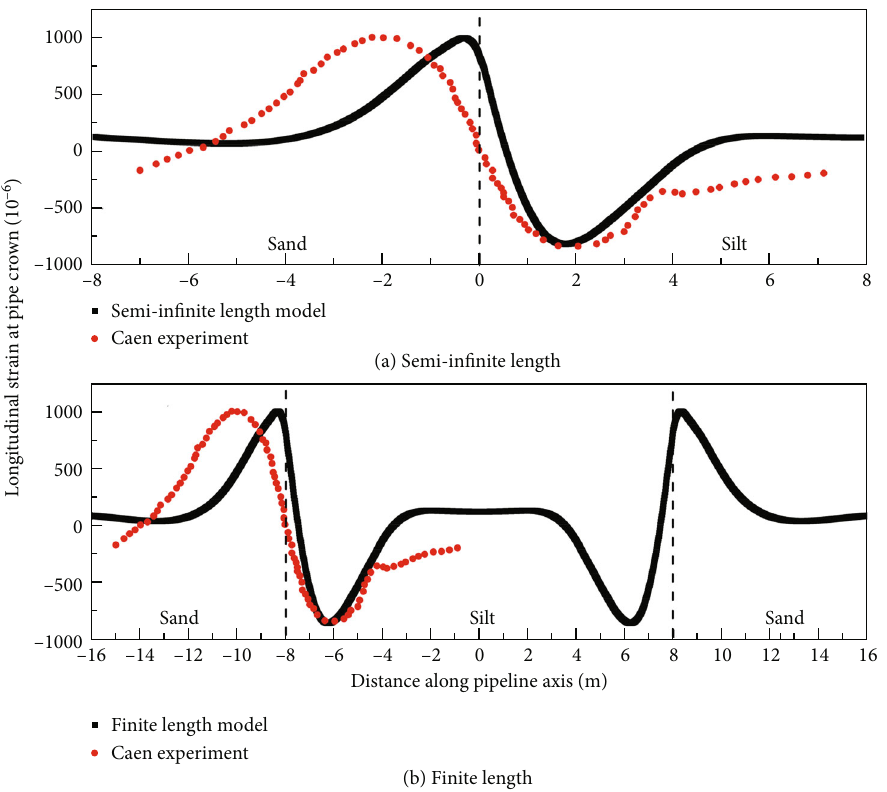
Figure 5: Comparison results of longitudinal strains at pipe crown subjected to di ff erential frost heave between Caen experiment in France and di ff erential frost heave models in this paper: (a) semi-in fi nite length model and (b) fi nite length model.